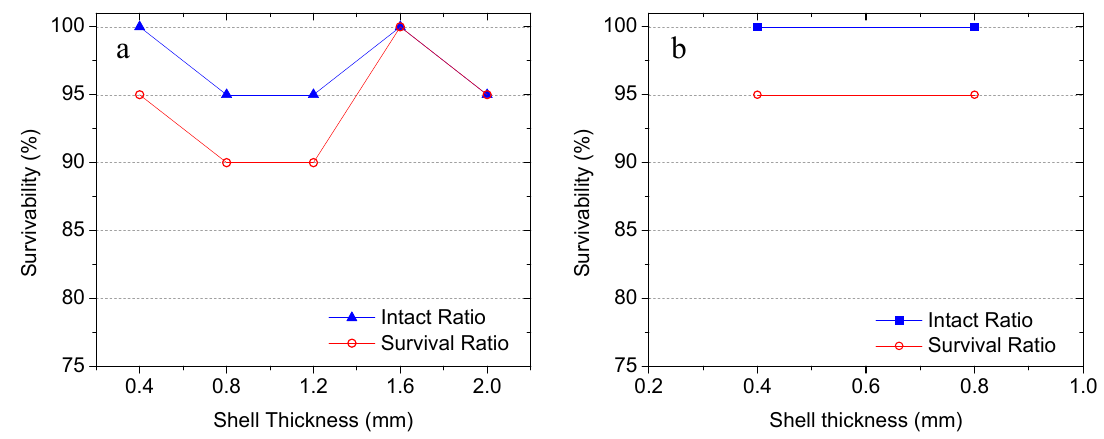
Figure 7. Influence of shell thickness on the survivability of capsules with aspect ratios of ( a ) 1.5:1:1, and ( b ) 2:1:1.